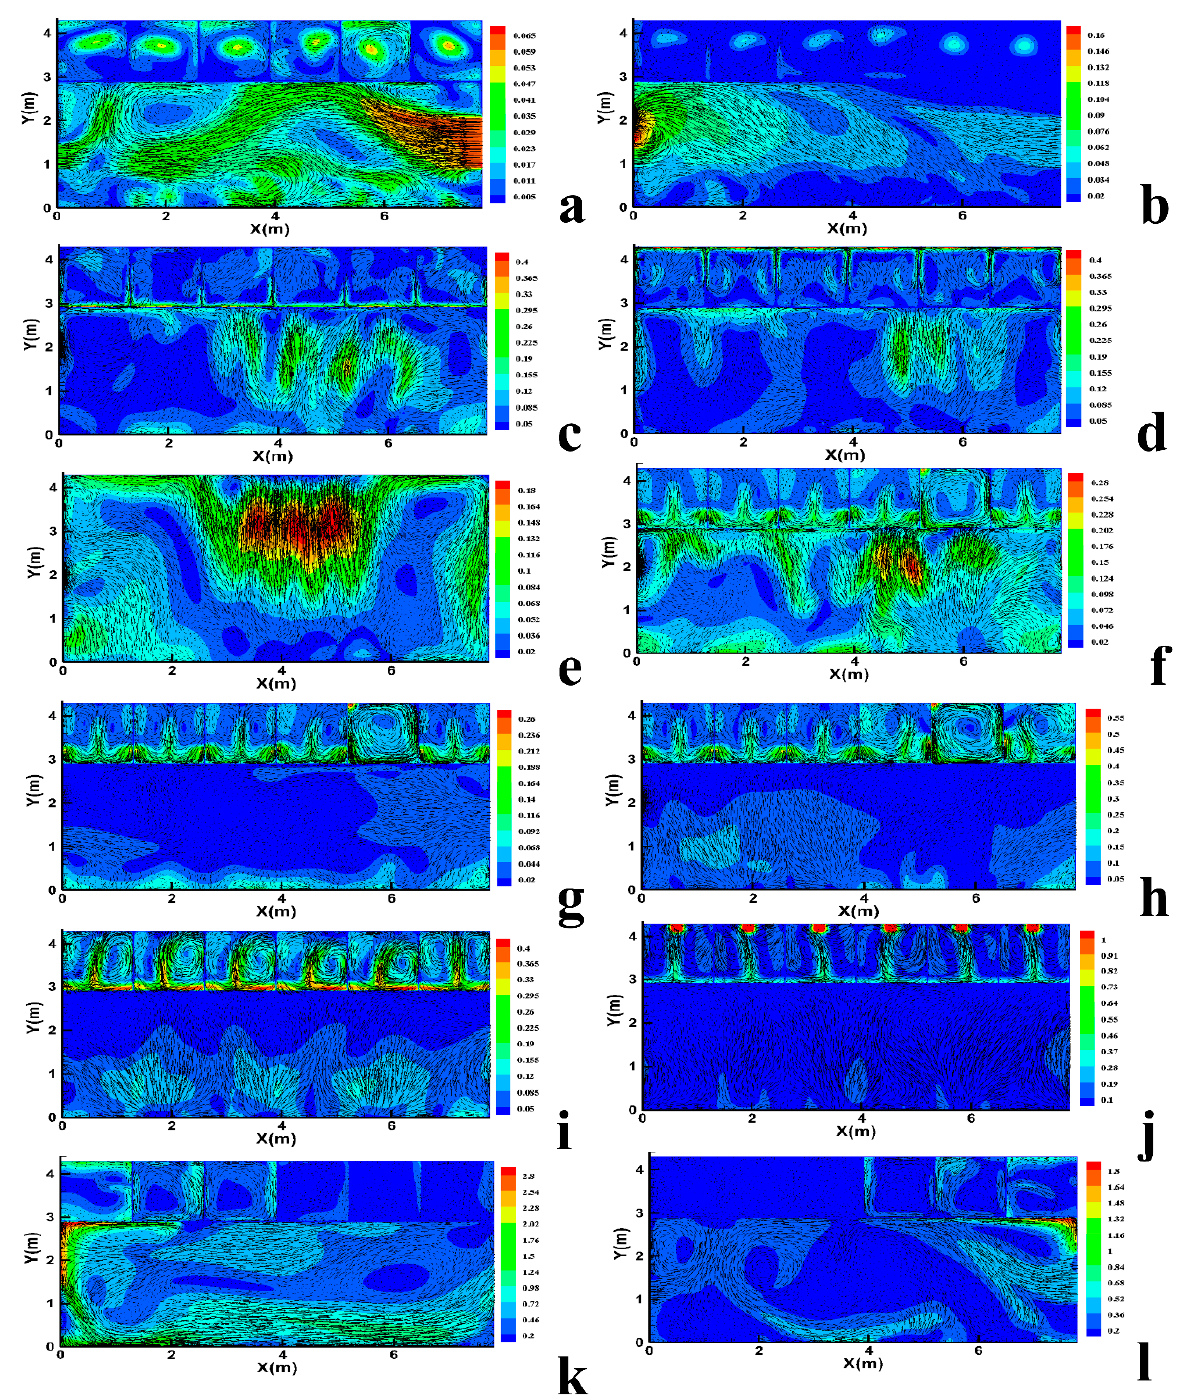
Figure 6. Velocity vector contours in different cases (Z = 1.5 m, ACH = 15): ( a – l ) MV-1–IJV-7.